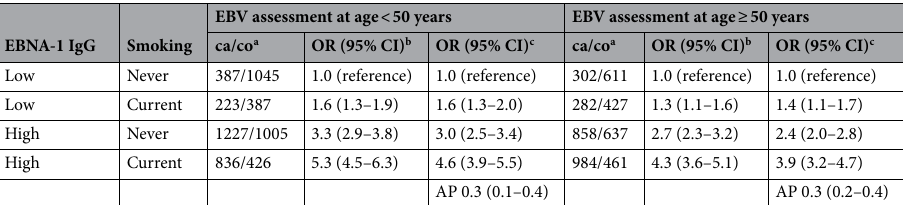
Table 3. OR with 95% CI of developing MS among subjects categorized by EBNA1 status and smoking, stratified by age at EBV assessment. AP with 95% CI between high EBNA1 IgG and smoking. a Number of exposed cases and controls b Adjusted for age, sex, residential area, study, and ancestry c Adjusted for age, sex, residential area, study, ancestry, infectious mononucleosis, adolescent body mass index, DRB1*1501, DRB1*0301, DRB1*1303, DRB1*0801, A*0201, B*4402, B*3801, B*5501, DQA1*0101, DQB1*0302,